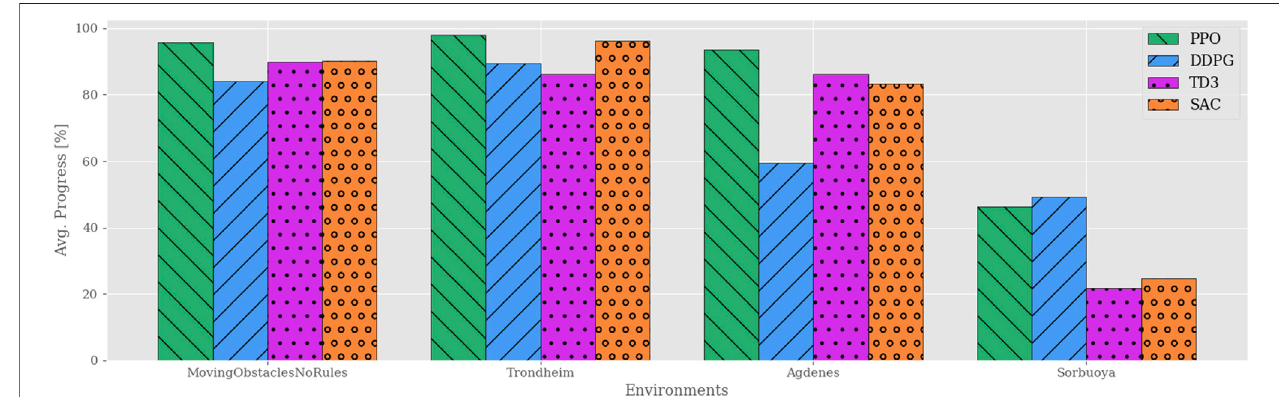
FIGURE 9 | Path progression performance comparison between RL algorithms in training and real-world simulation environments using the simpli fi ed reward function. Compared to the previous reward function, the off-policy RL algorithms show a drastic increase in performance. In contrast, PPO now performs considerably worse in the Sorbuoya environment, yet maintains its performance in the other testing environments and is still the best performer overall.